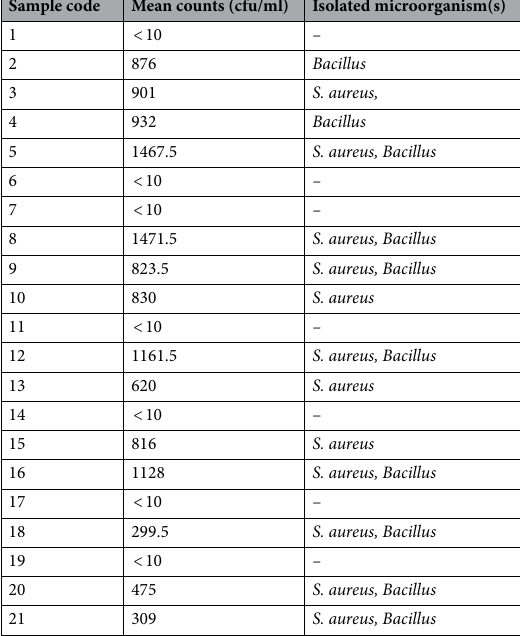
Table 3. Microbial counts and identification of the isolated microorganism(s).